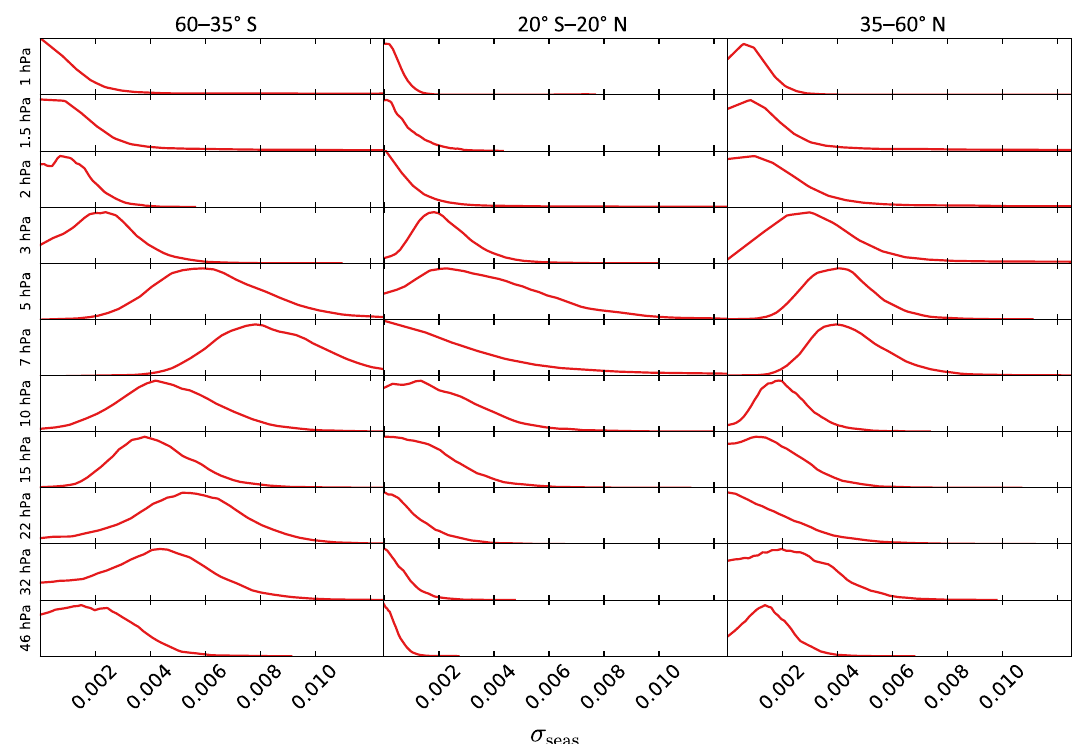
Figure A5. Recovered posteriors on σ seas from the DLM analysis performed in Sect.